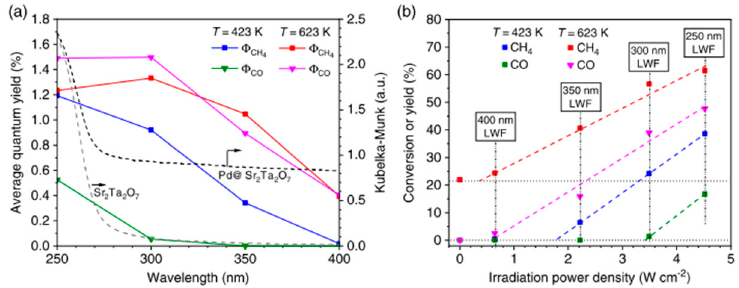
Figure 51. ( a ) UV-vis spectra of Sr 2 Ta 2 O 7 and Pd/Sr 2 Ta 2 O 7 and the quantum efficiency of methane, carbon monoxide at 423 and 623 K. ( b ) Conversion of methane and yield of carbon monoxide using various long-wavelength cutoff filters. The horizontal axis is irradiation power density with each cutoff filter. Reprinted from [70]. Copyright (2019) by John Wiley & Sons, Inc.